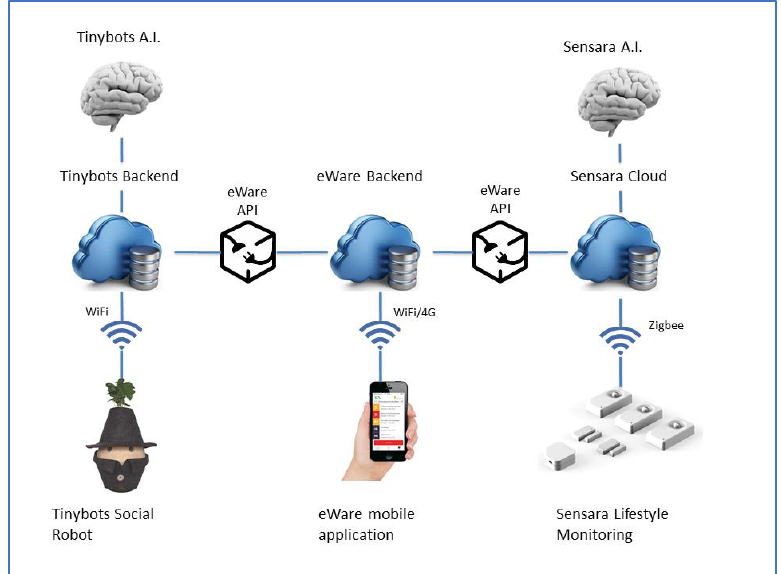
Figure 1. The eWare ecosystem.